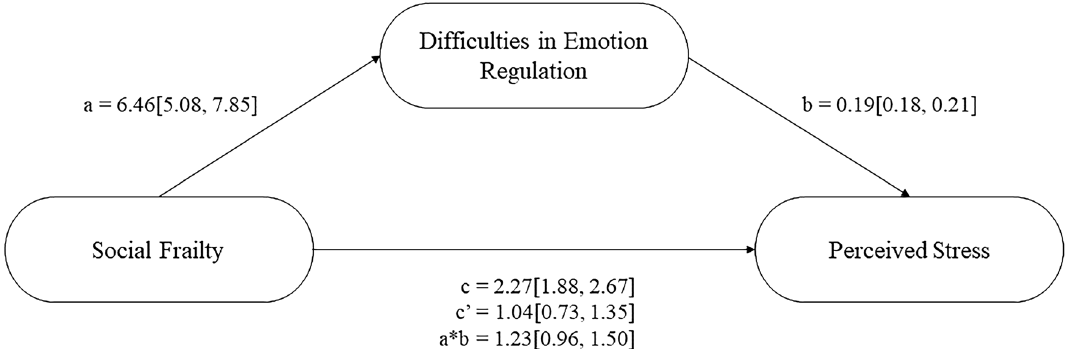
Figure 1. Difficulties in emotion regulation as a partial mediator between social frailty and perceived stress.